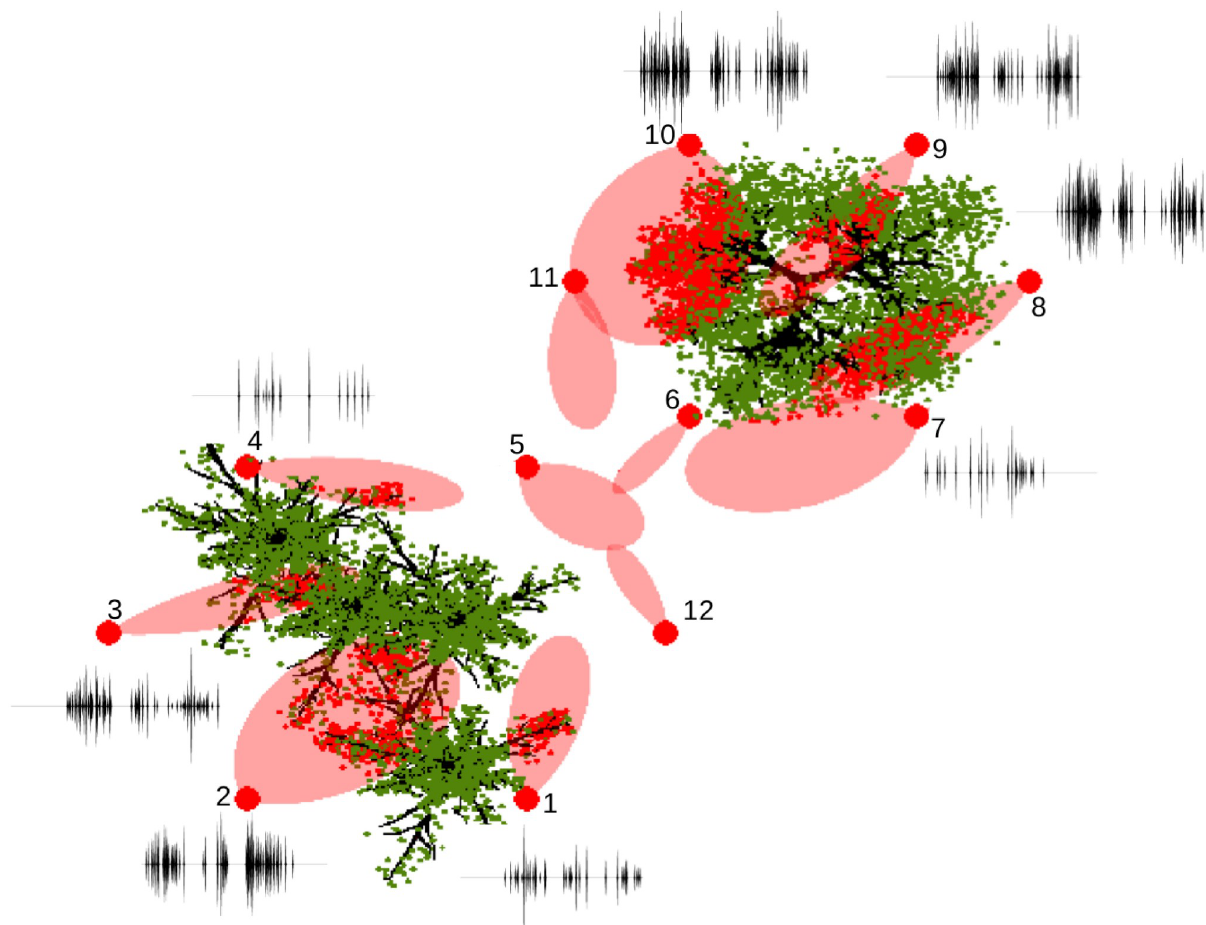
Fig 7. Simulation scenario II. A UAV navigates across a simulated forest following a “8” shaped route. Twelve sampling points are taken along the route. Sonar beamwidth varies. The -3 dB contour of the sonar beams are highlighted in red. The waveforms of impulse responses are plotted at each sampling location.